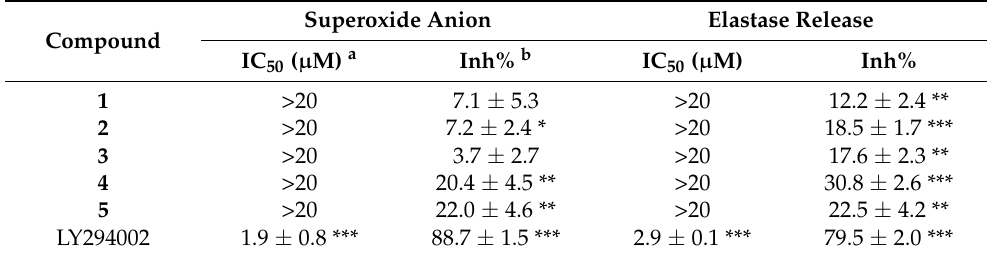
Table 4. Inhibitory effects of compounds 1 – 5 on superoxide anion generation and elastase release, zº by human